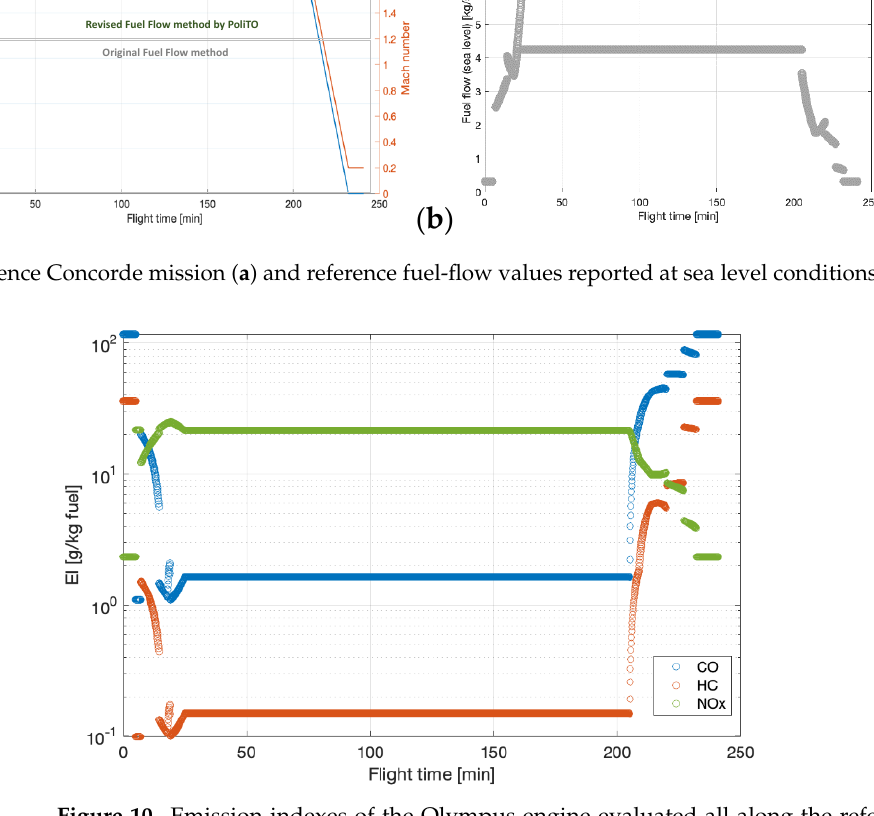
Figure 11. Theoretical maximum EI percentage variation due to the substitution of traditional fuel with a 100% biofuel. However, considering that biofuel blend ratios are currently bounded up to fix limits (as discussed in Section 2), the impact of a blend ratio from 10% to 100% is reported in Figure 12 for the three different species and for the six different biofuel families considered